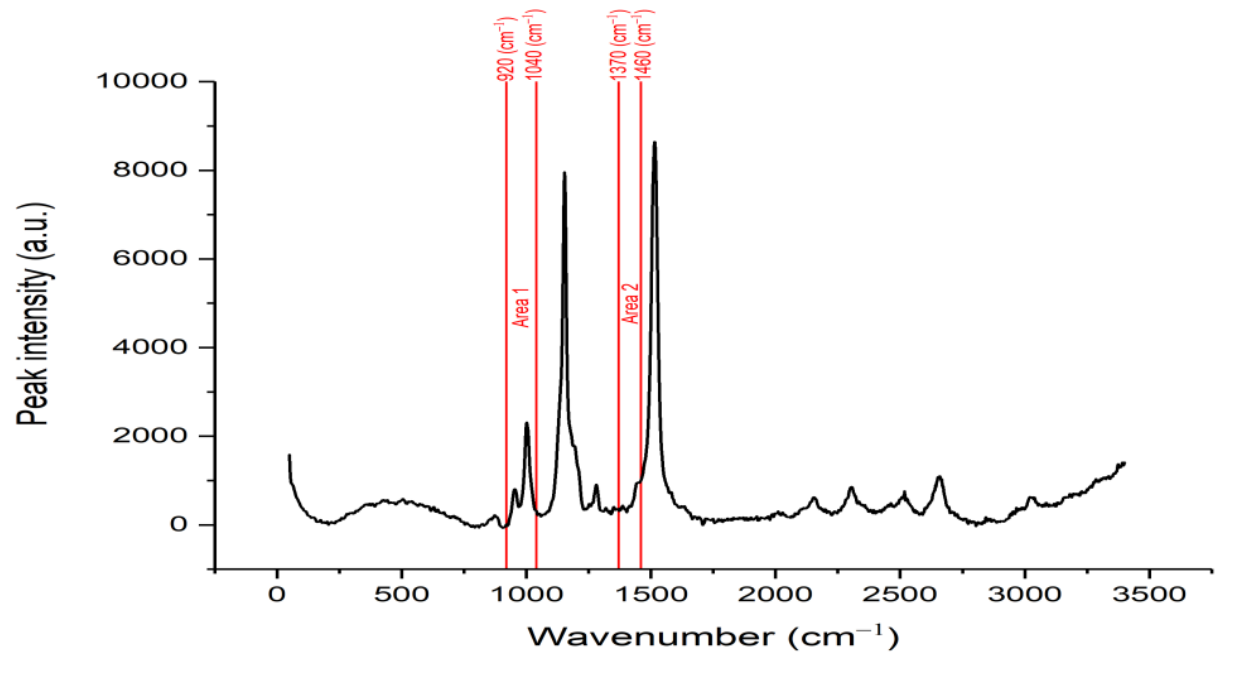
Figure 1. Raw Raman spectra of an oil palm fruit.